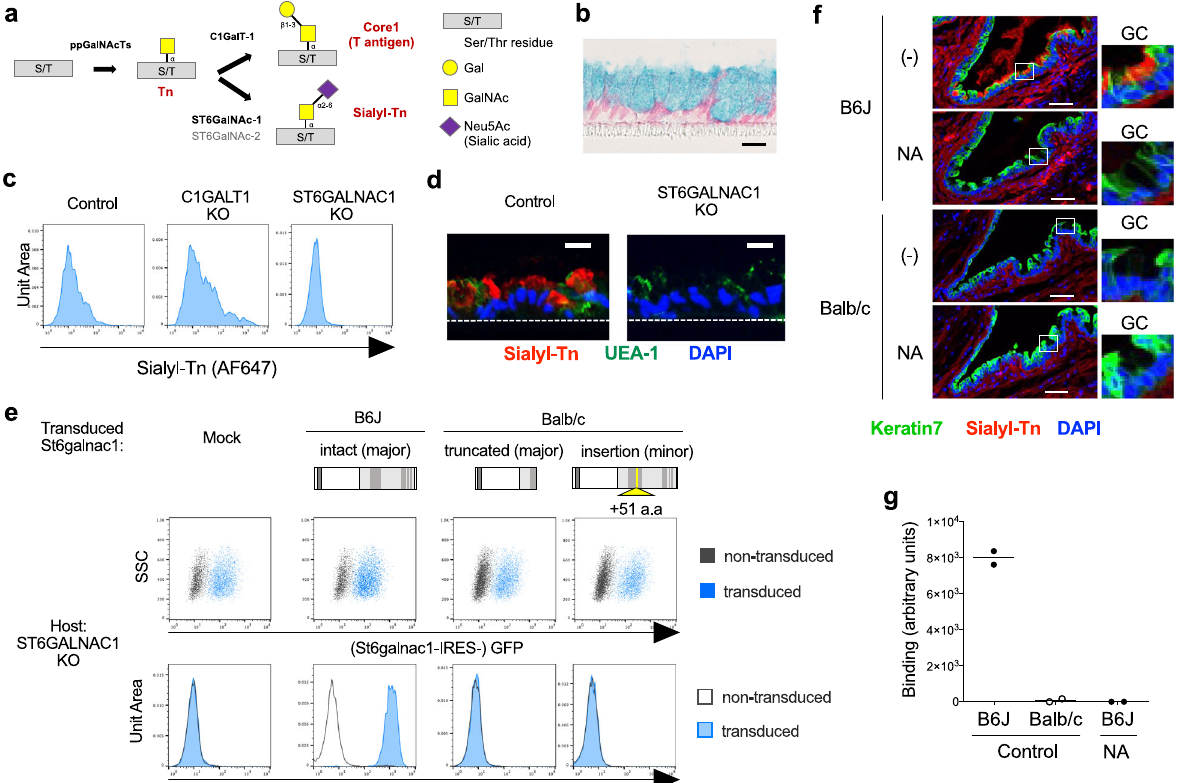
Fig. 3 | Defective St6galnac1 activity in Balb/c goblet cells. a Biosynthetic pathways of Tn, Core1, and sialyl-Tn. S/T, serine or threonine residue. b AB and Kernechtrot staining of differentiated HT29-MTX-E12 (E12) cell line. Bar, 20 μ m. Polyclonal knockout (KO) of C1GALT1 or ST6GALNAC1 in E12 cells by genome editing affects sialyl-Tn expression assessed by FACS ( c ) and immunostaining ( d ). UEA-1, Ulex Europaeus Agglutinin I. Bar, 20 μ m. e ST6GALNAC1 -KO E12 cells were transduced with cloned St6galnac1 sequences. Expression levels of sialyl-Tn and GFP in transduced (blue histogram) and un-transduced (gray empty histogram)